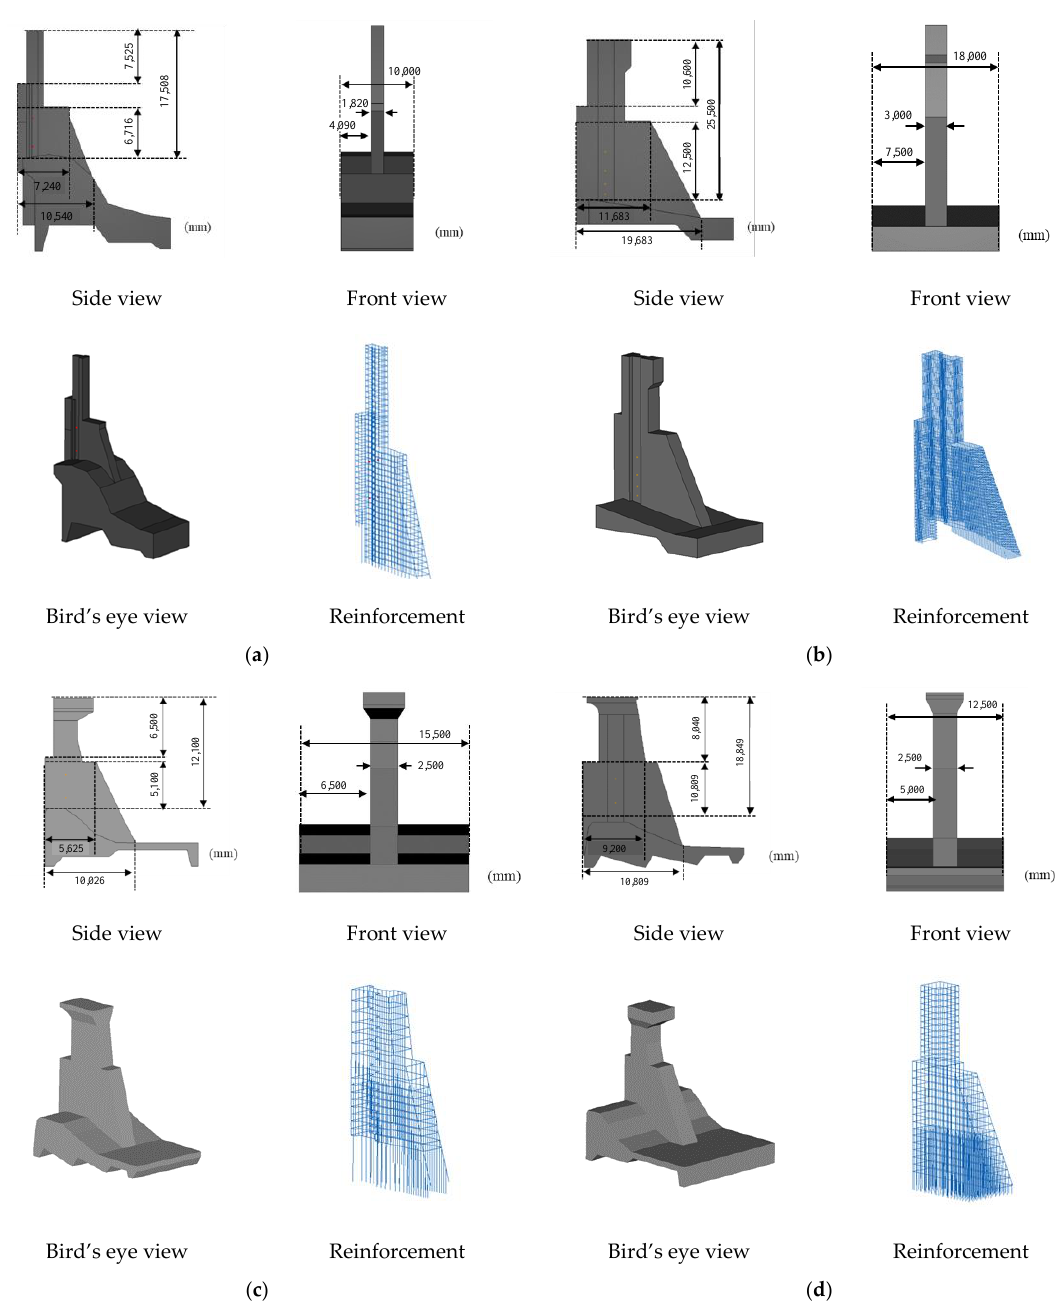
Figure 11. FEM analysis models of dam pier: ( a ) TYPE-A dam pier; ( b ) TYPE-B dam pier; ( c ) TYPE-C dam pier; ( d ) TYPE-D dam